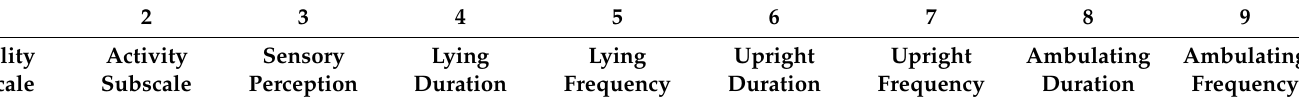
Table 4. Pearson Correlations of the Braden Scale Subscale Scores and Movement Features (N = 913). 1